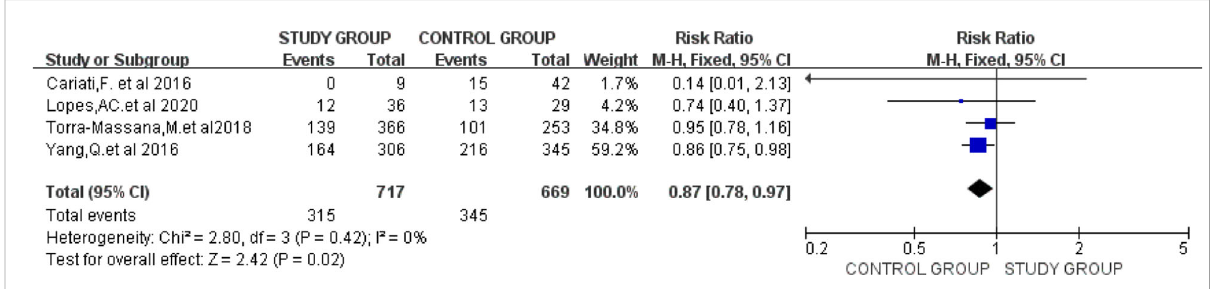
FIGURE 4 Forest plot showing the results of Meta-analysis, comparing study and control men for differences in clinical pregnancy rates.